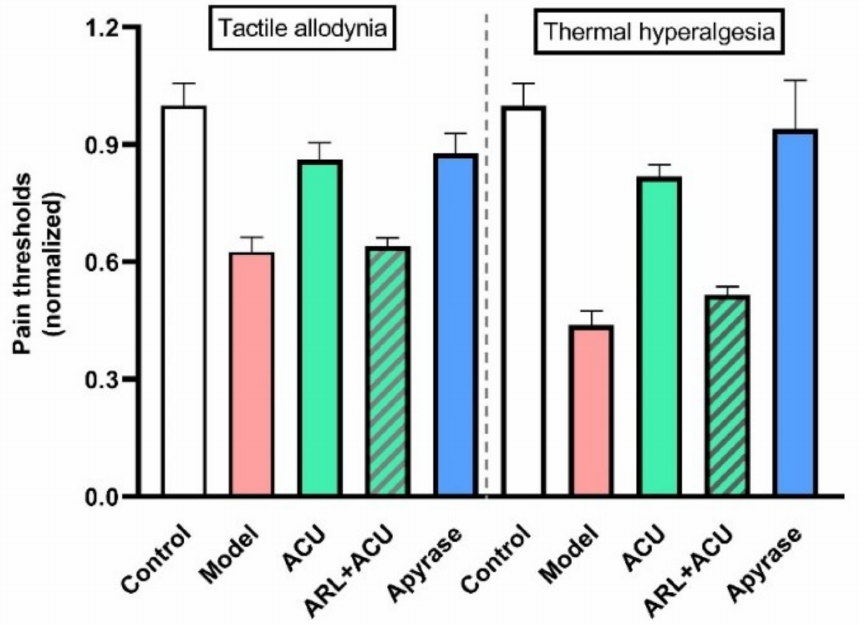
Figure 17. Effect of ecto-nucleotidases’ activities on acupuncture analgesia of ankle AA rats. ARL (100 µ M, 50 µ L) was pre-injected in ST36 20 min ahead of needling ( n = 4–5). Apyrase (50 units/mL, 50 µ L), soluble form of CD 39, was administrated at the same time point, 50 min before the behavioral test. Establishing the inflammation pain and acupuncture intervention was referred to in Figure 5. The data are based on Zuo et al. 2022